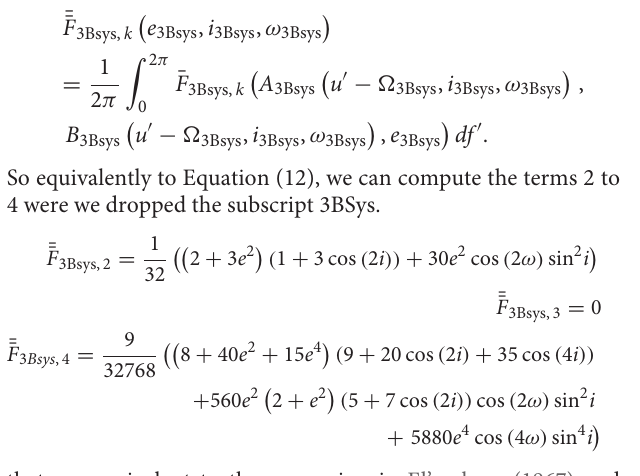
FIGURE 7 | Luni-solar zonal 1 e maps for semi-major axis equal to 67045.39km (XMM Newton’s orbit) for different values of initial inclination with respect to the + orbiting plane of the Moon. The initial inclination and the argument of the perigee are measured with respect to the Moon’s plane. (A) Initial inclination (B) Initial inclination 5deg. (C) Initial inclination 10deg. (D) Initial inclination = = inclination 30deg. (H) Initial inclination 35deg. (I) Initial inclination = = inclination 55deg. (M) Initial inclination 60deg. (N) Initial inclination = = inclination 75deg. (R) Initial inclination 80deg. (S) Initial inclination = =